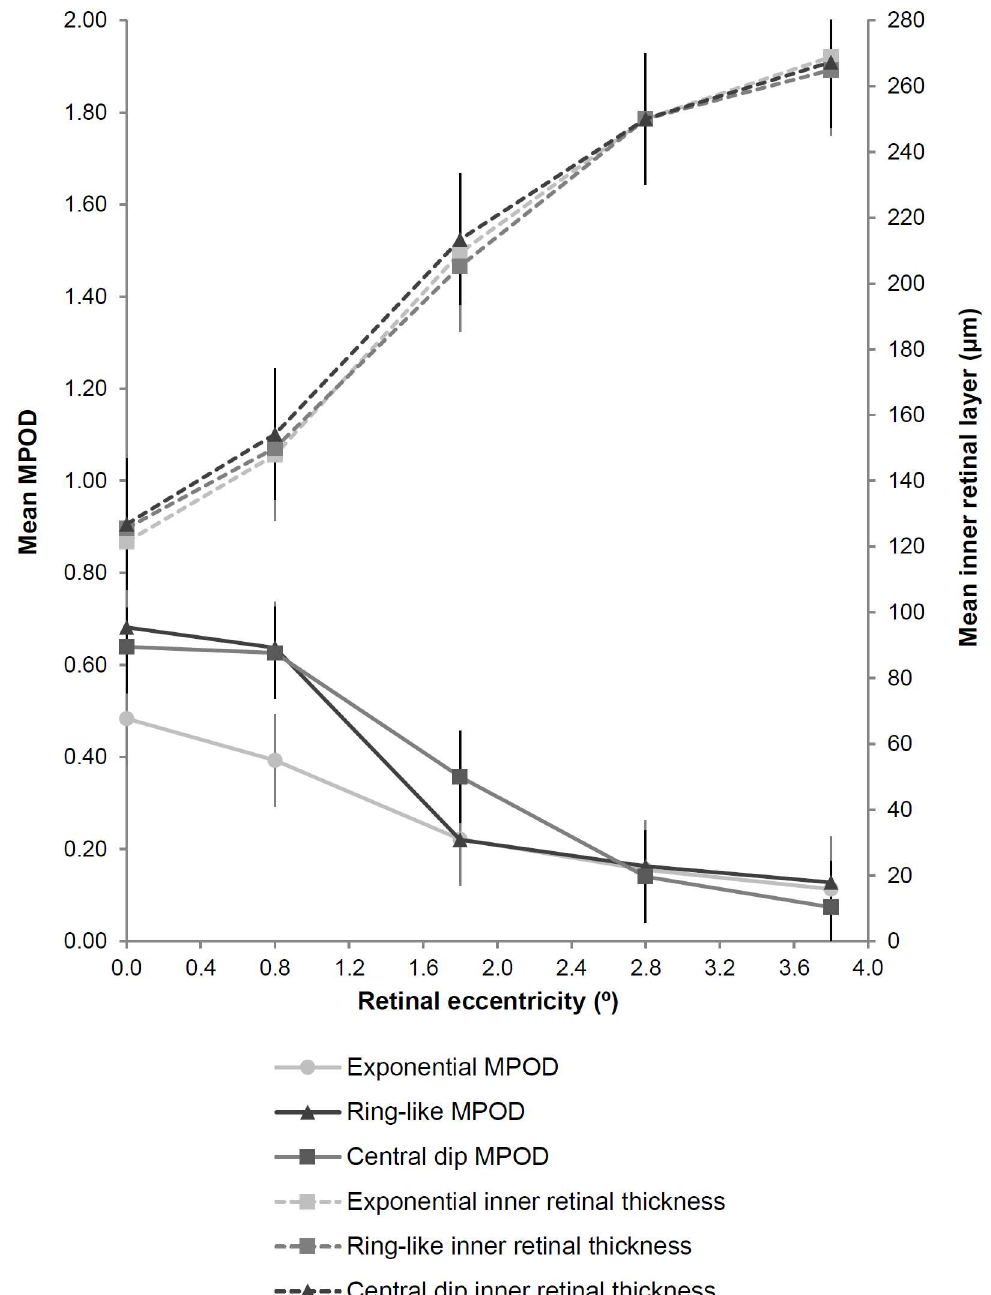
Fig 2. Variation in mean MPOD (primary y-axis) plotted against retinal eccentricity (x-axis) according to spatial profile phenotype with corresponding inner retinal layer thickness plotted on the secondary y- axis. Error bars indicate ± SD. AlthoughMPOD at 0˚ and 0.8˚ is increasedin the ring-likeand central dip comparedto the exponential spatialprofile groups, there is no significantdifference in inner retinal layer thickness betweenthe